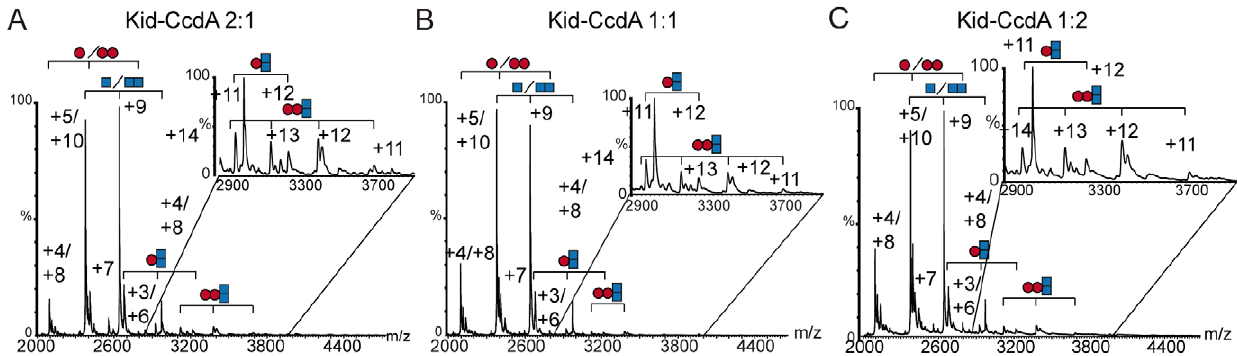
Figure 7. NMS profile of the interactions of Kid with CcdA proteins at different toxin-antitoxin ratios. (A), Mass spectrum obtained at a Kid:CcdA ratio of 2:1. (B), Mass spectrum obtained at a Kid:CcdA ratio of 1:1.(C) Mass spectrum obtained at a Kid:CcdA ratio of 1:2. All the protein mixtures were performed in 100 mM ammonium acetate pH 6.7. The lowest protein concentration was 10 m M in all cases. CcdA protein is represented with maroon circles and Kid protein is represented with blue squares. Each complex found is represented with the appropriate combination of squares and circles.